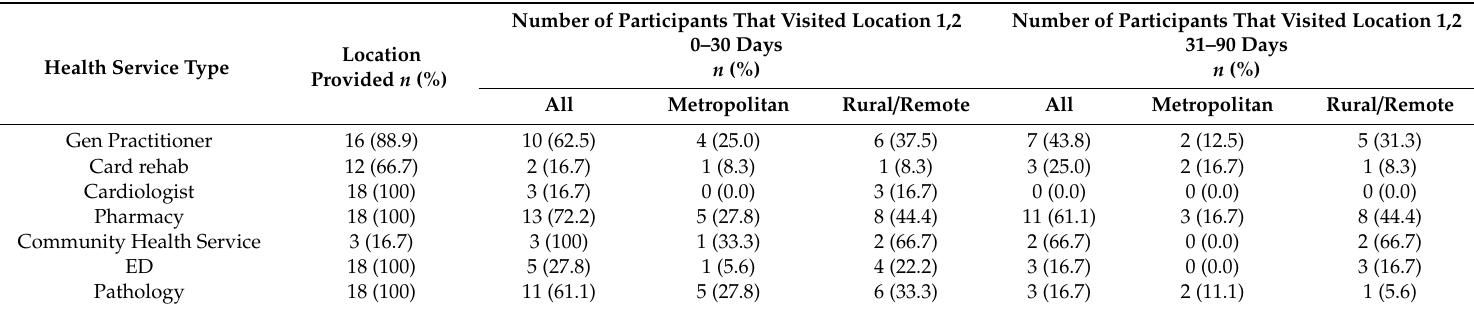
Table 3. Participant access to services at 30 and 90